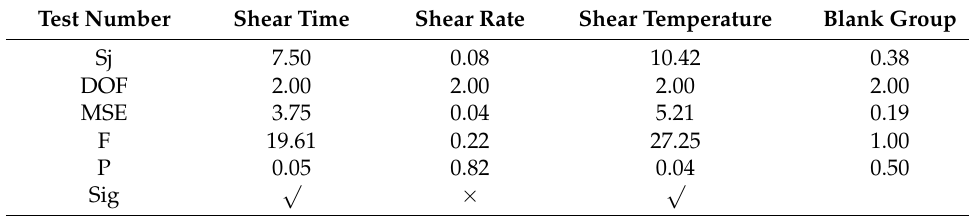
Table 9. Failure temperature variance analysis results.